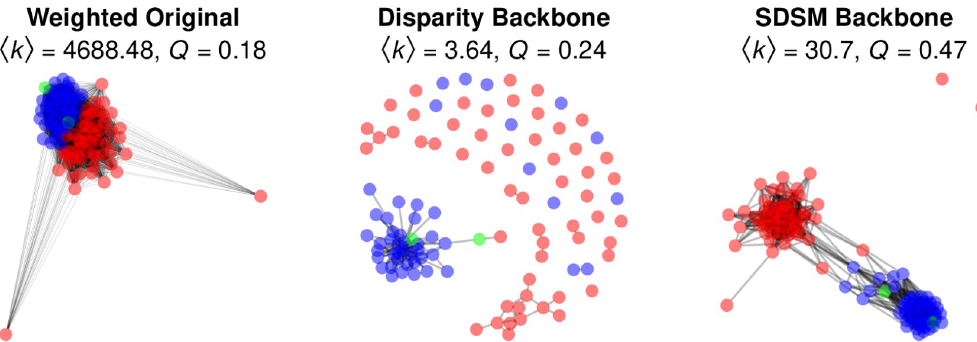
Fig 5. Extracting the backbone of a bipartite projection of bill co-sponsorship in the 115 th US